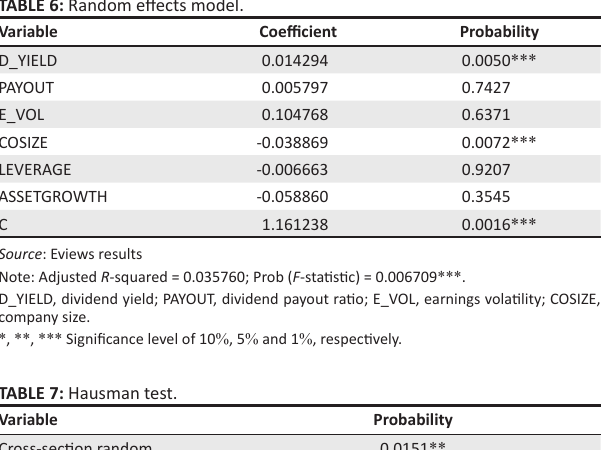
TABLE 7: Hausman test. Variable Probability Cross-section random